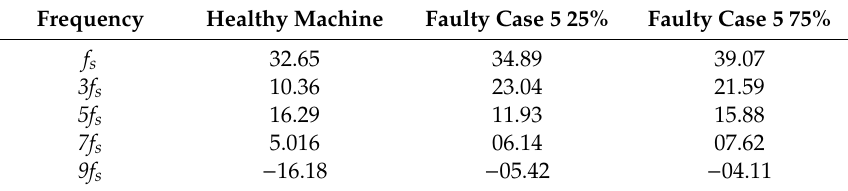
Table 5. Current harmonic components comparison due to case 5 (in dB).